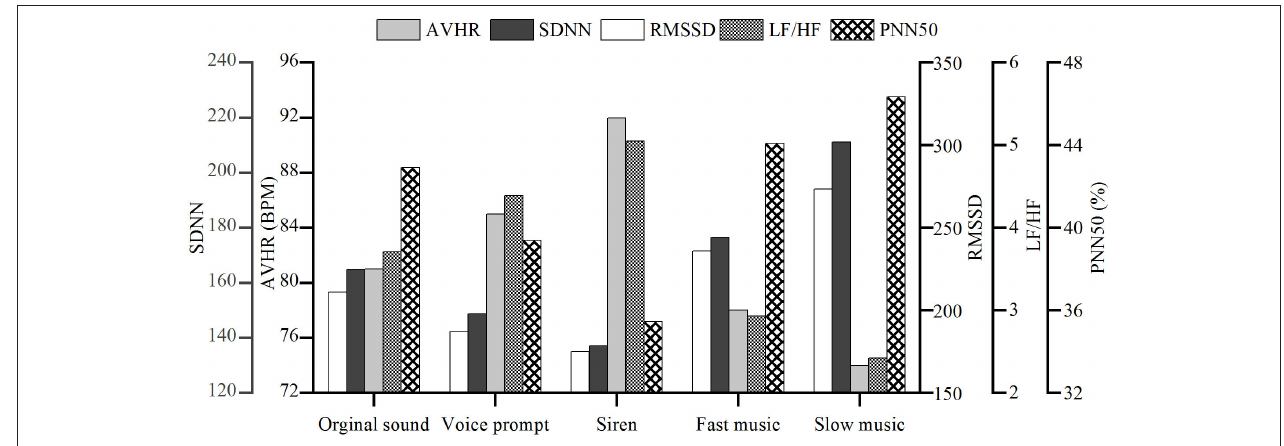
FIGURE 3 | Change of heart rate variability (HRV) indicator for different sound scenarios.